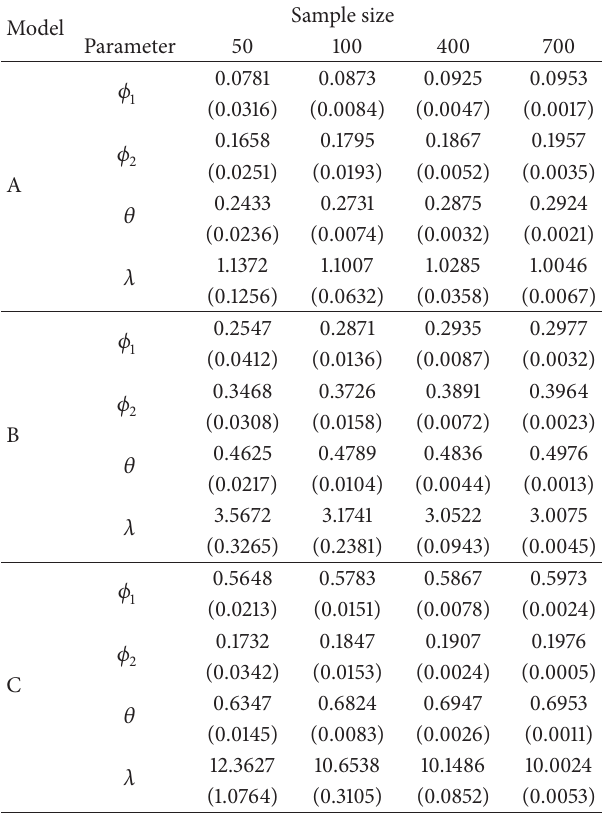
Table 1: Sample mean and mean square error (in brackets) for models A, B, and